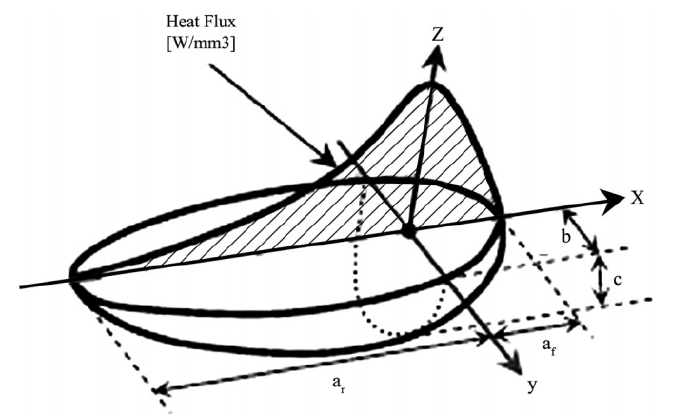
Figure 5. Double ellipsoidal heat source model. Table 2. Heat source parameters.